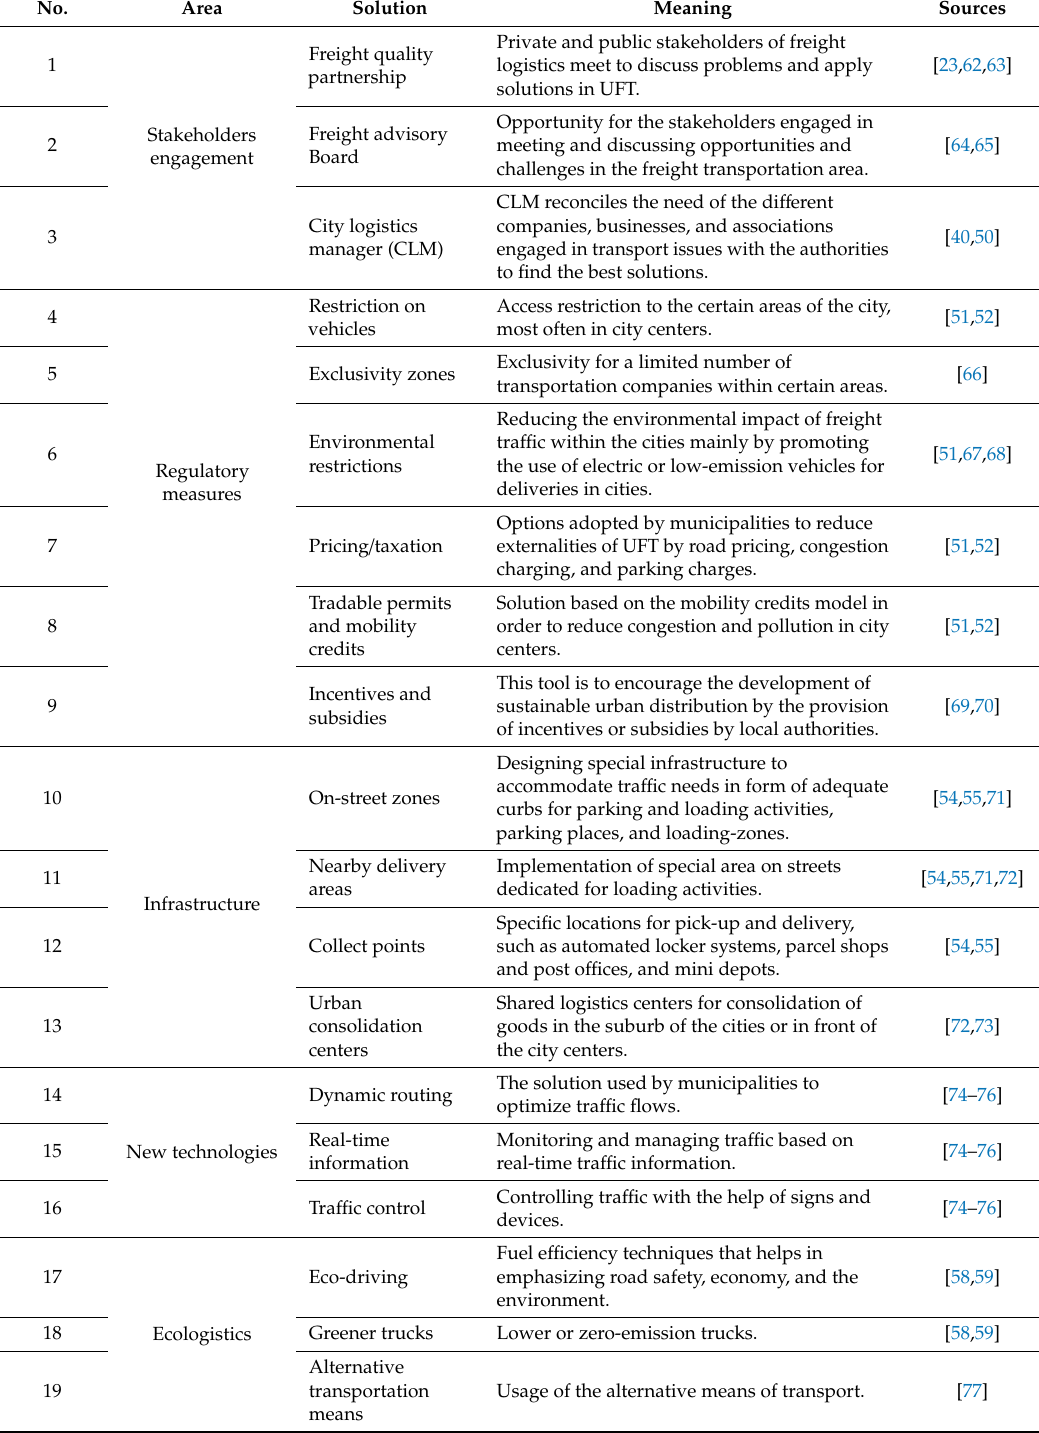
Table 1. Groups of CL